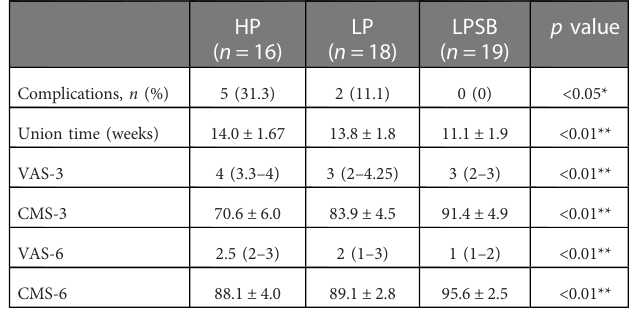
TABLE 2 Postoperative complications and outcomes of the three